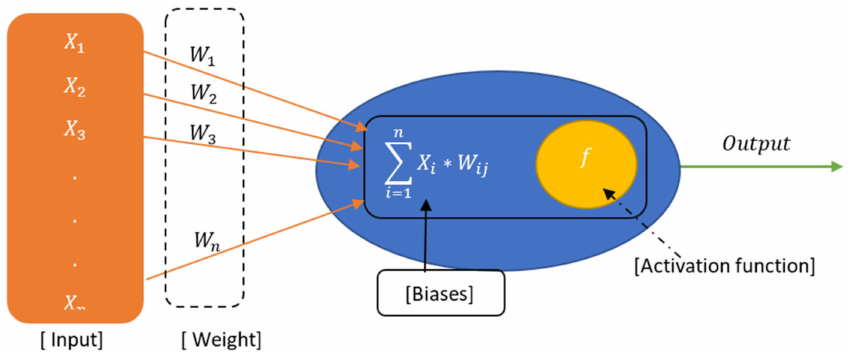
Figure 9. Feedforward neural network